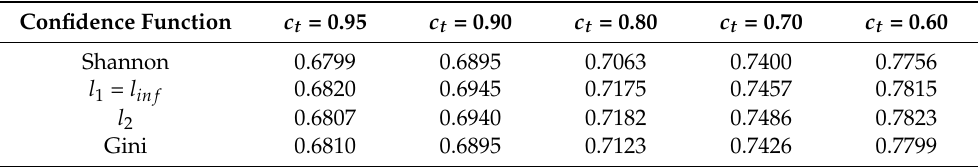
Table 3. Comparison of accuracy obtained by the evaluated confidence functions for different coverage thresholds c t .